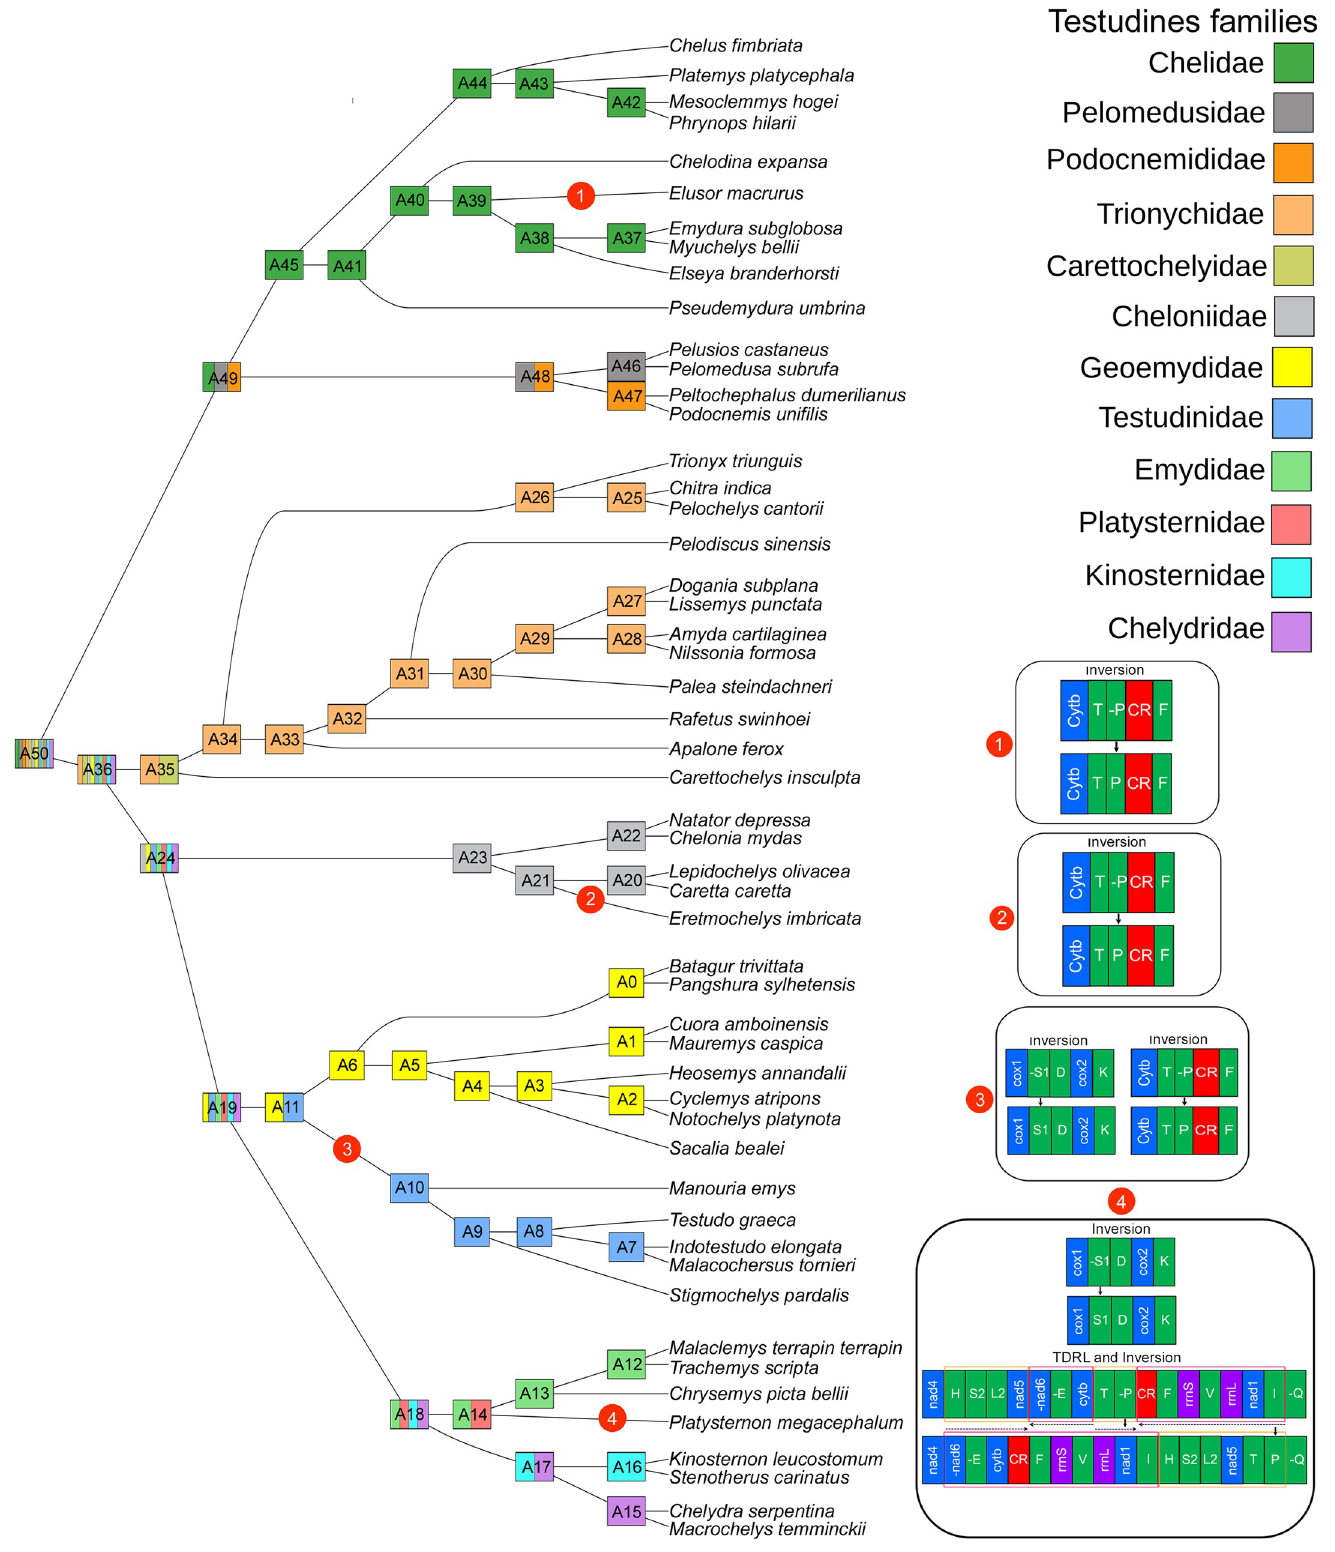
Fig 4. Gene-order based topology based on TreeREx analysis revealed the gene arrangement scenario within 52 Testudines species. All internal nodes are shared color as per phylogenetic clustering. Four gene arrangement scenarios are superimposed next to the tree. https://doi.org/10.1371/journal.pone.0225233.g004 PLOS ONE | https://doi.org/10.1371/journal.pone.0225233 April 23,